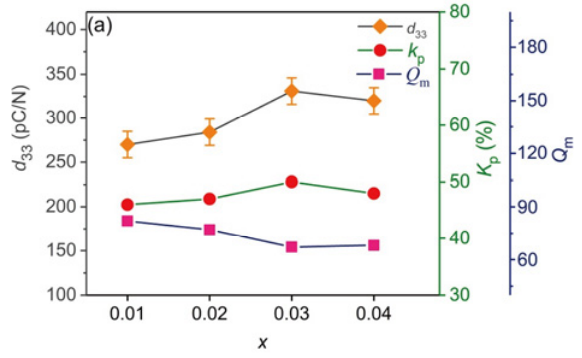
Fig. 4 Summarized results of d 33 , k p , and Q m of LKNNS  EuNZ  x BZ ceramics.